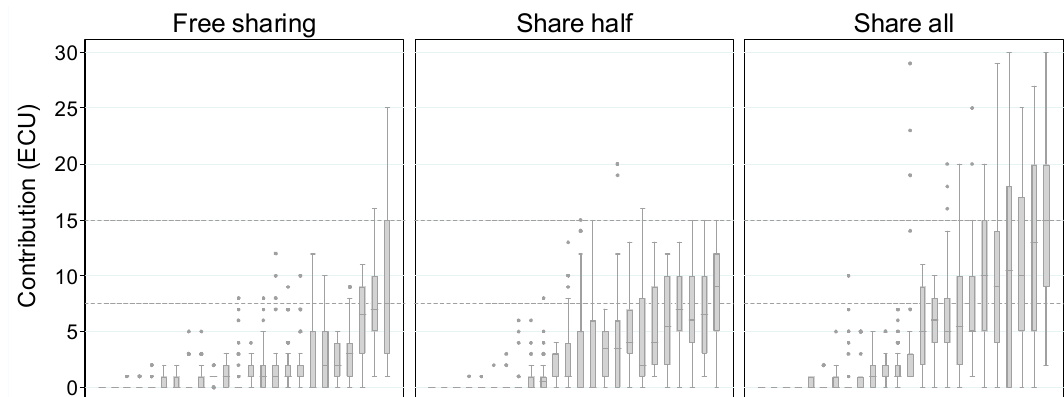
Figure 4. Individuals. Each bar shows the boxplot of a participant. Within each treatment, individuals are ordered by their mean contribution. The upper horizontal dashed line marks the average endowment over 42 periods (15 ECU, that corresponds to contributing everything on average). The lower dashed line marks half of the average endowment (7.5 ECU, corresponding to contributing half of the endowment on average).